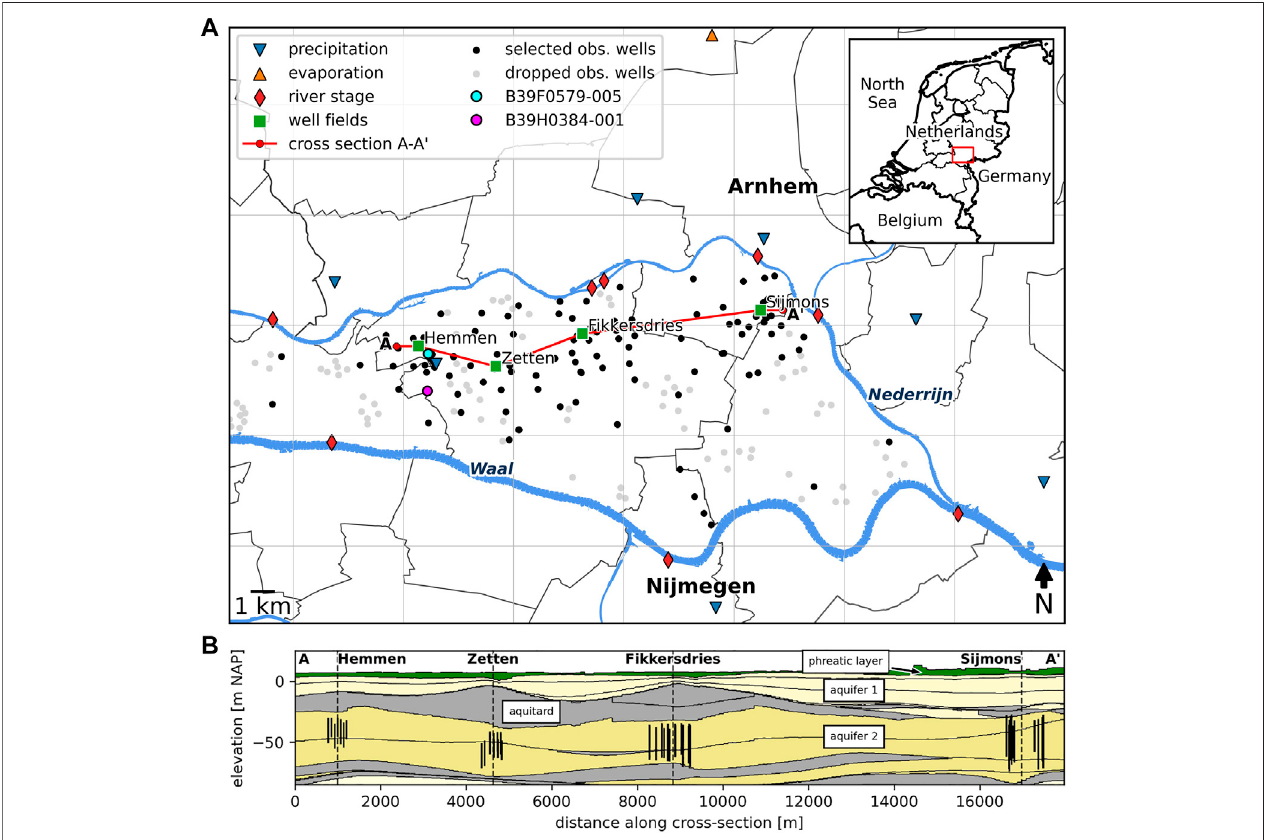
FIGURE 3 | Overview of study area with locations of observation wells, and locations at which stresses are measured (A) . Cross-section of the subsurface along well fi elds showing well screens, aquifers and aquitards (B) .